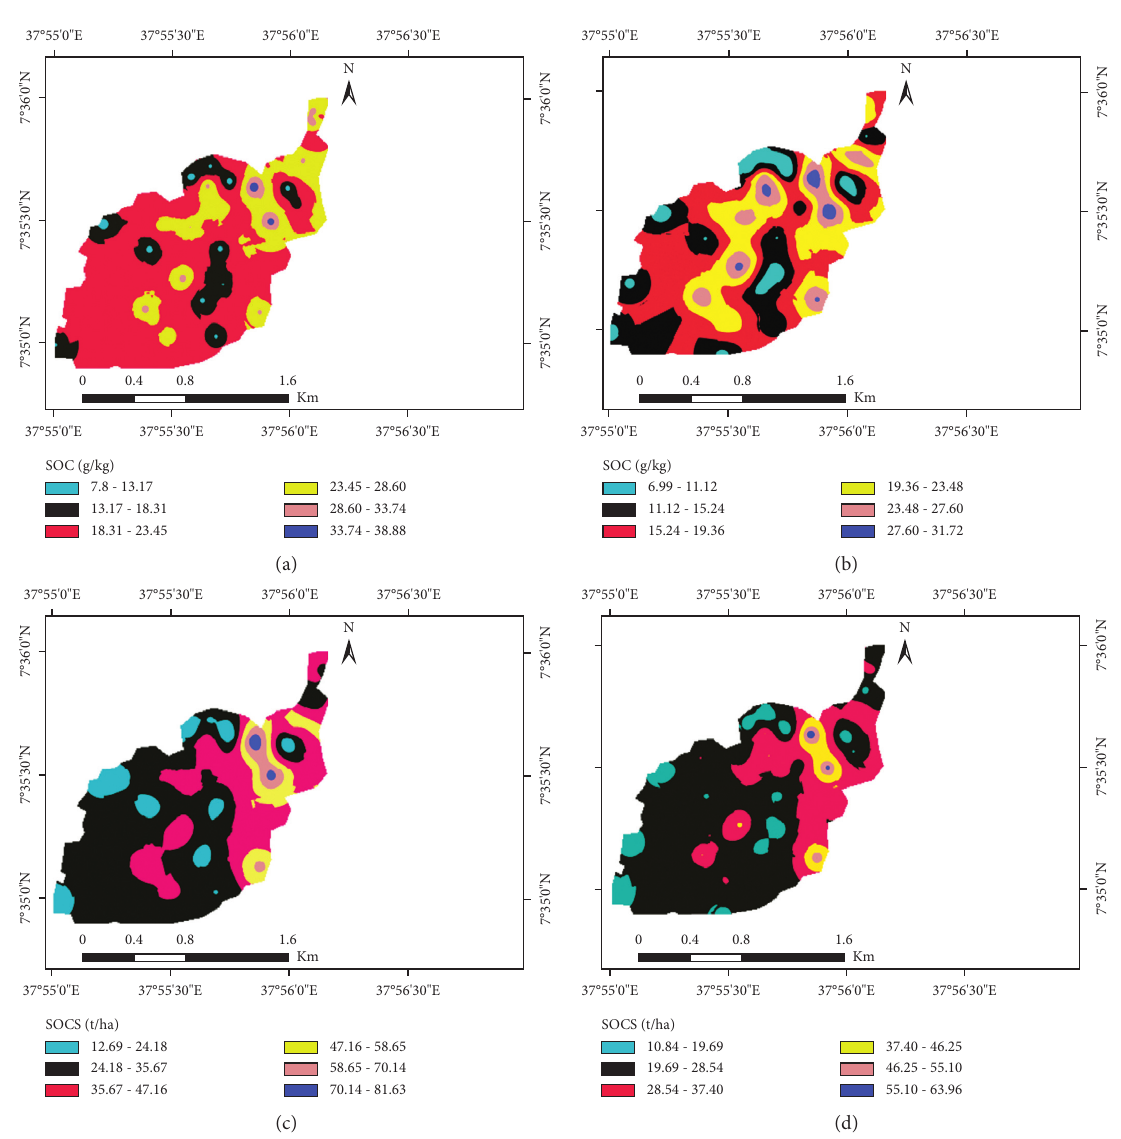
Figure 4: The spatial distribution maps of the SOC and SOCS at both sampling depths of the study